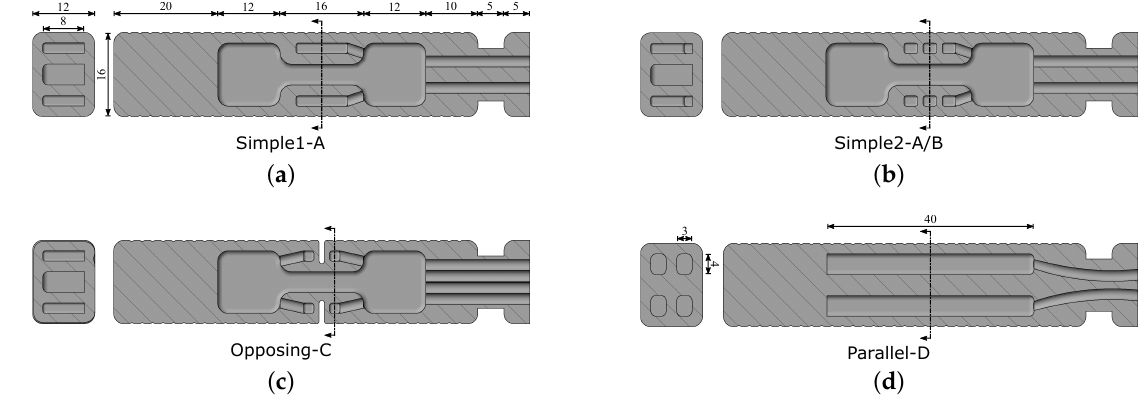
Figure 1. Transverse (left) and longitudinal (right) cross-sections of the four internal geometries used in the fabricated prototypes, showing insertion routes for the input tubing. ( a ) Simple1, simple side-pockets without supporting internal walls; ( b ) Simple2, simple side-pockets with two supporting internal walls; ( c ) Opposing, opposing side-pockets; ( d ) Parallel, four parallel pockets.